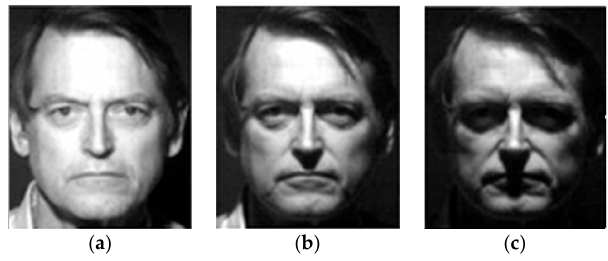
Figure 4. The same image shown with changes in brightness: ( a ) original image; ( b ) slight change in brightness; and ( c ) obvious change in brightness.